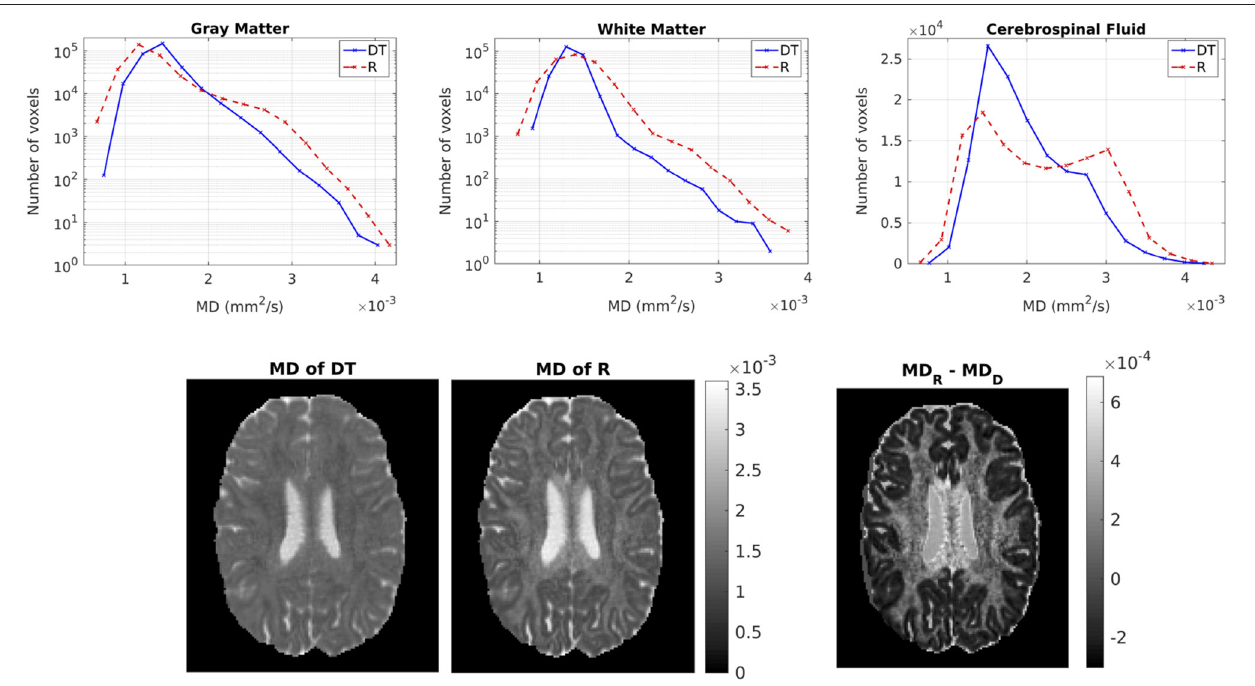
FIGURE 6 | (Top) Histogram of the MD of the two tensors in voxels identified as GM (left), WM (center), and CSF (right). The solid lines represent D w and the dashed lines represent R w . (Bottom) MD (in mm 2 /s) of D w (left), MD of R w (center), difference of MDs (right) for axial slice 70. The MDs of the two tensors are plotted on the same scale.